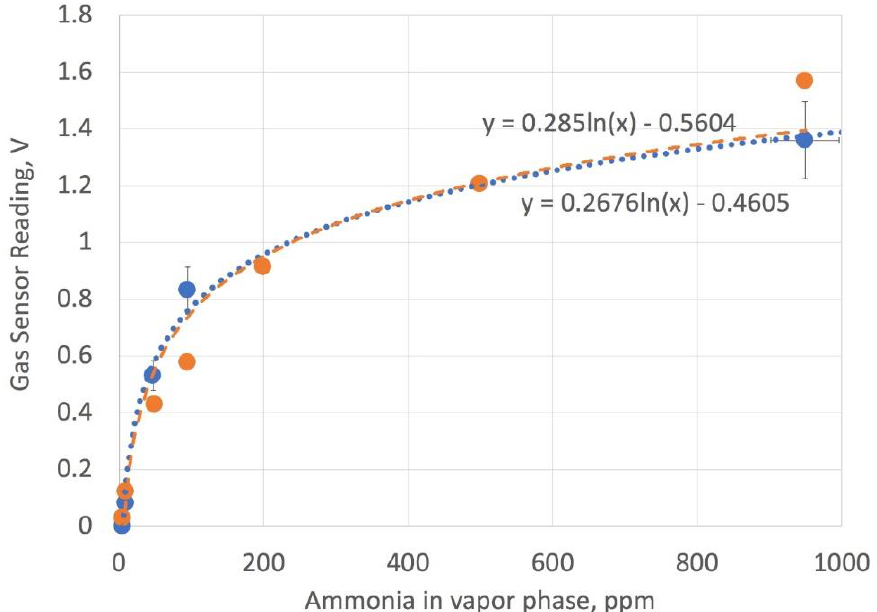
Figure 10. Calibration readings using the electronic nose assembly with ammonia solutions (blue filled circles and dashed line), compared to manufacturer’s data (orange filled circles and orange dashed line). The load resistor is set at 2.5 k Ohms.